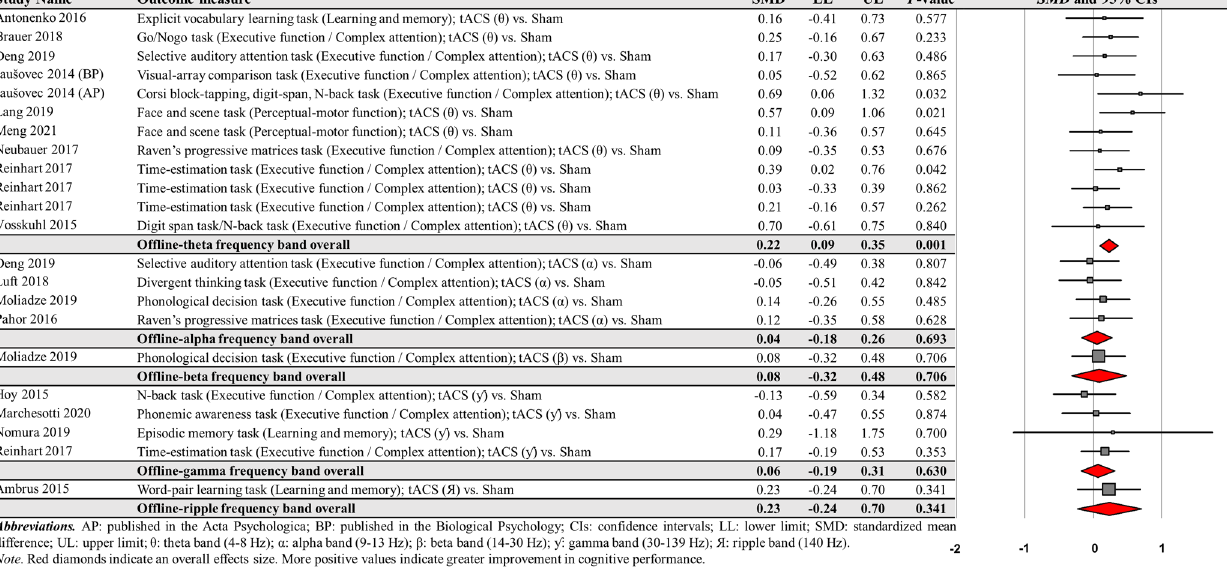
Fig. 9 Cognitive performance comparisons after of fl ine-tACS with speci fi c frequency bands. Meta-analytic fi ndings show potential effects of of fl ine-tACS protocols with theta frequency band on changes in cognitive